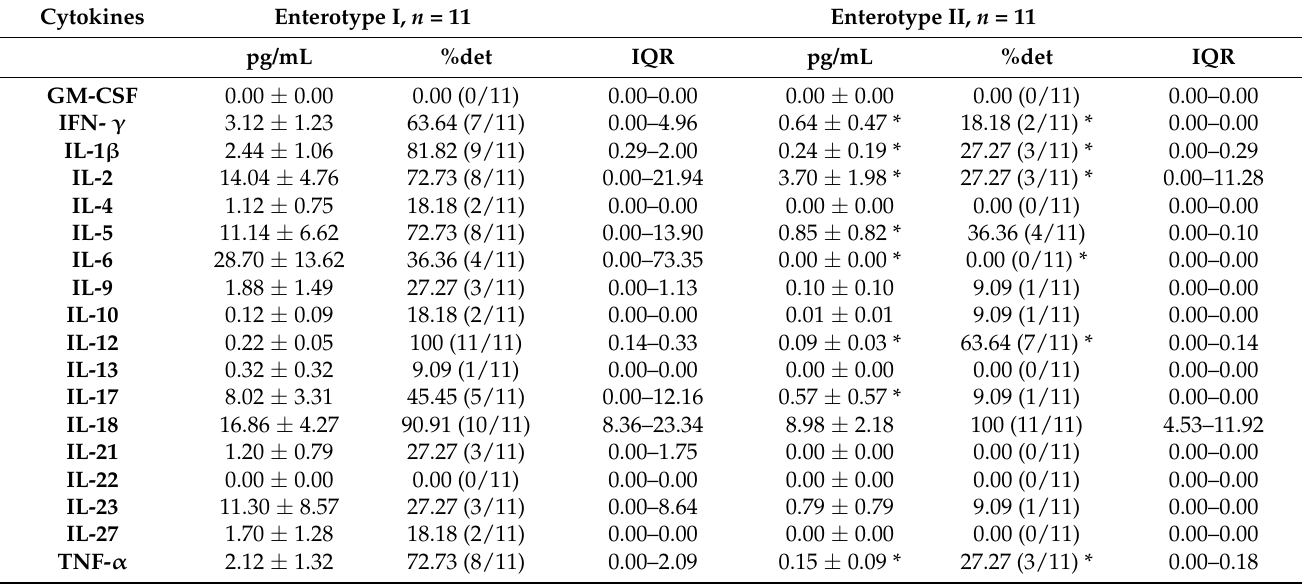
Table 6. Cytokine composition of umbilical cord plasma from each maternal